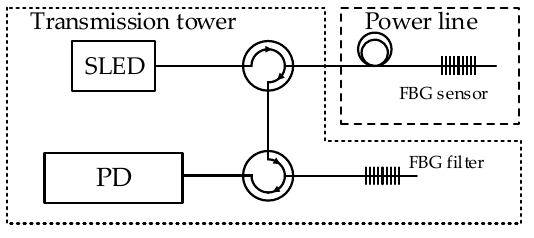
Figure 2. Interrogation system variant 2.